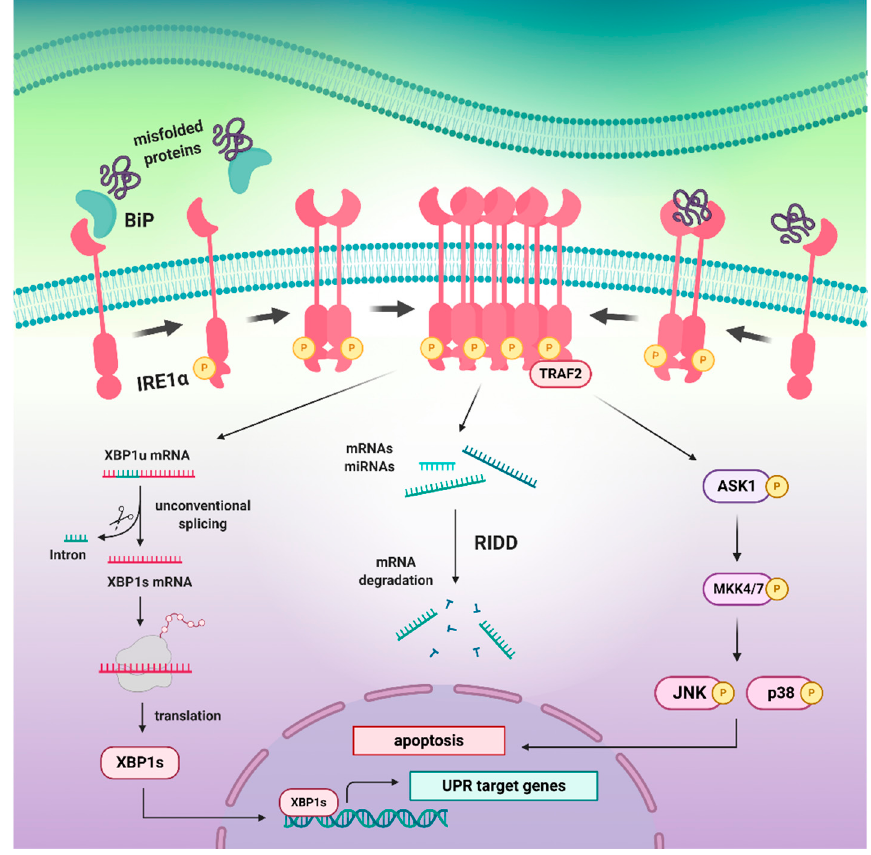
Figure 2. The activation of human inositol-requiring enzyme type 1 α (IRE1 α )-dependent signaling pathway with its downstream targets. The IRE1 α activation occurs upon association of binding immunoglobulin protein (BiP) with misfolded protein and its subsequent dissociation from IRE1 α , or alternatively upon direct binding of misfolded protein by the N-terminal luminal domain (NLD) of IRE1 α . The following oligomerization, often of more than four IRE1 α molecules, is required for further trans-autophosphorylation process and activation of kinase and RNase domains. The full kinase/RNase activity positively correlates with the increasing number of IRE1 α oligomers. Acti- vated IRE1 α induces the following cellular processes: The unconventional splicing of x-box binding protein 1 ( XBP1 ) mRNA, regulated IRE1-Dependent Decay (RIDD) and TNF Receptor Associated Factor 2/apoptosis signal-regulating kinase 1/mitogen-activated protein kinase kinase4/7/c-Jun N-terminal kinase/p38 (TRAF2/ASK1/MKK4/7/JNK/p38) signaling pathway. The pro-survival or pro-apoptotic effect of IRE1 α activation is exerted by selective induction of its specific branches and depends on numerous factors, mainly the severity and timing of cellular stress